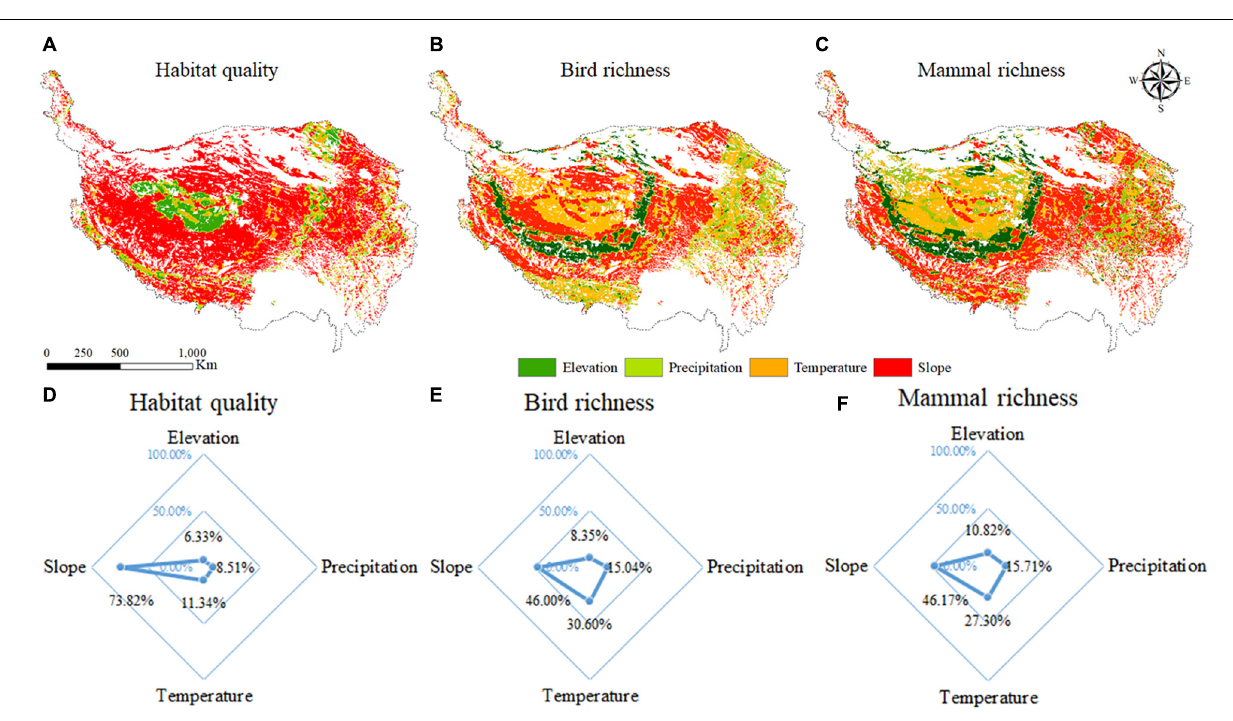
FIGURE 5 | The spatial distribution of the maximum interaction between grazing activities and the factor on habitat quality (A) ; bird species richness (B) ; and mammal richness (C) ; and the area proportion with the largest interaction effects between grazing activities and the factor on habitat quality (D) ; bird species richness (E) ; and mammal richness (F)